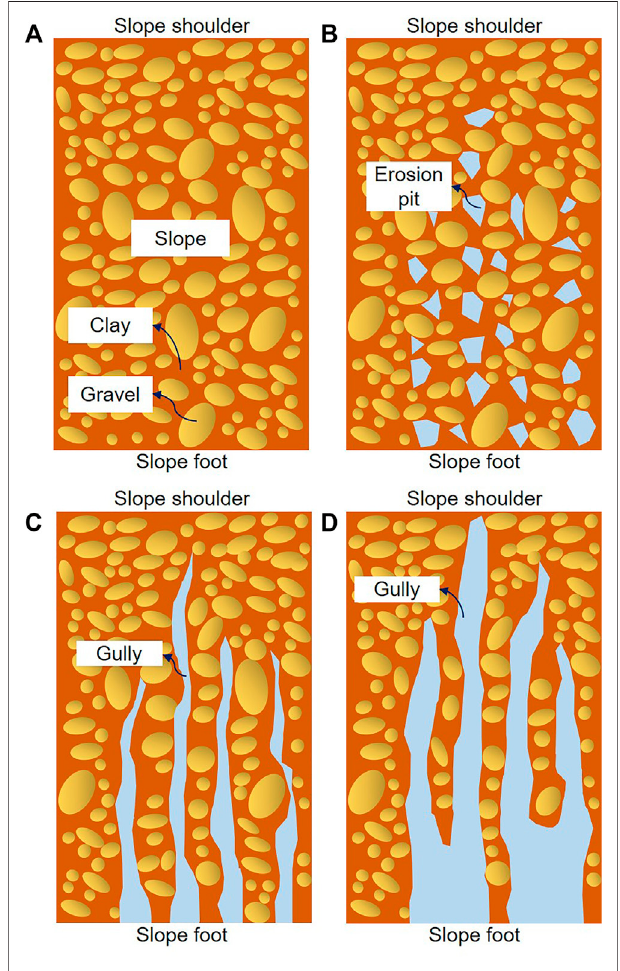
FIGURE 9 | Simpli fi ed diagram of slope erosion failure evolution law (gravel content 30%). (A) Initial slope (B) erosion pits (C) gully (D) gully